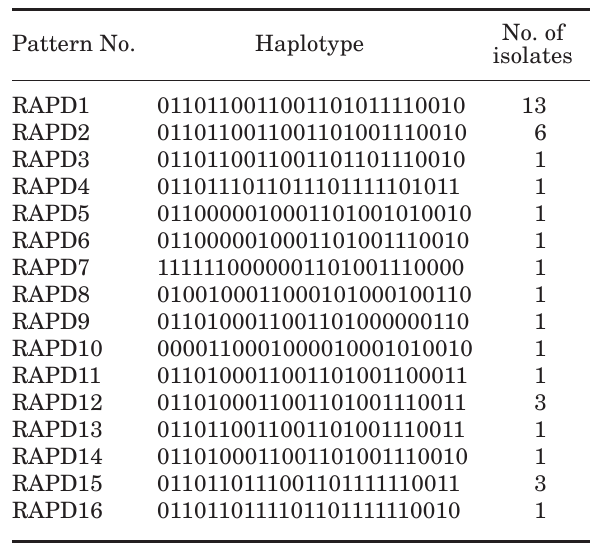
Table 3. Random amplified polymorphic DNA (RAPD) haplotypes obtained among the 43 Verticillium dahliae isolates tested.